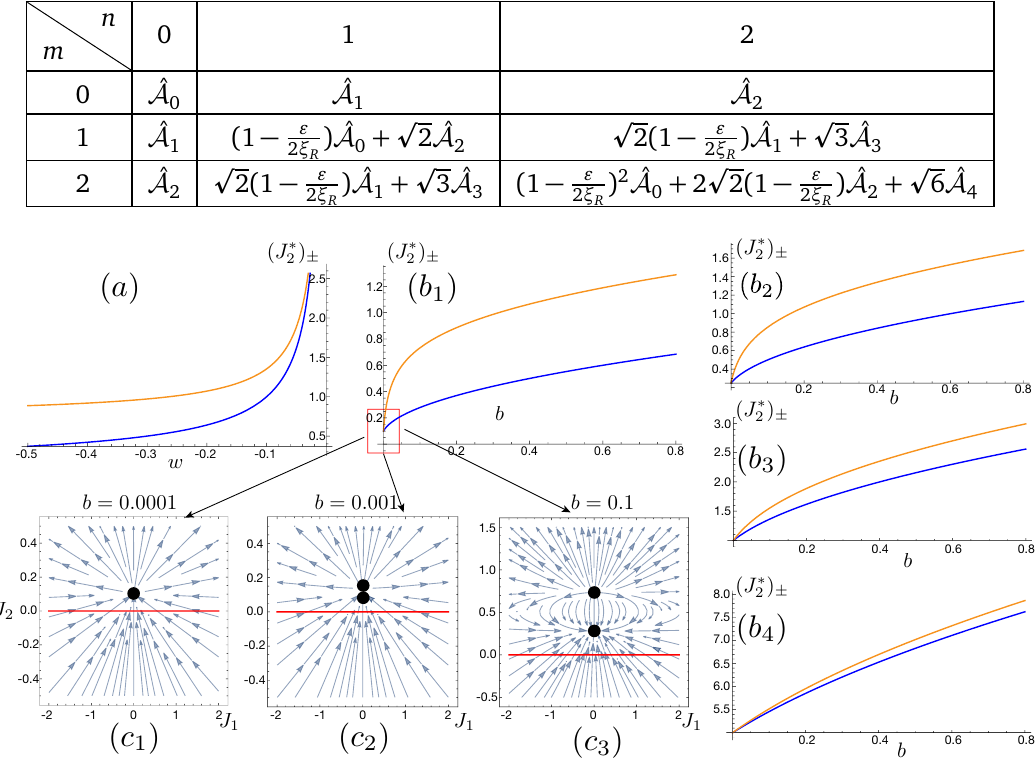
× ˆ for n , m = 0,1,2. A n A m